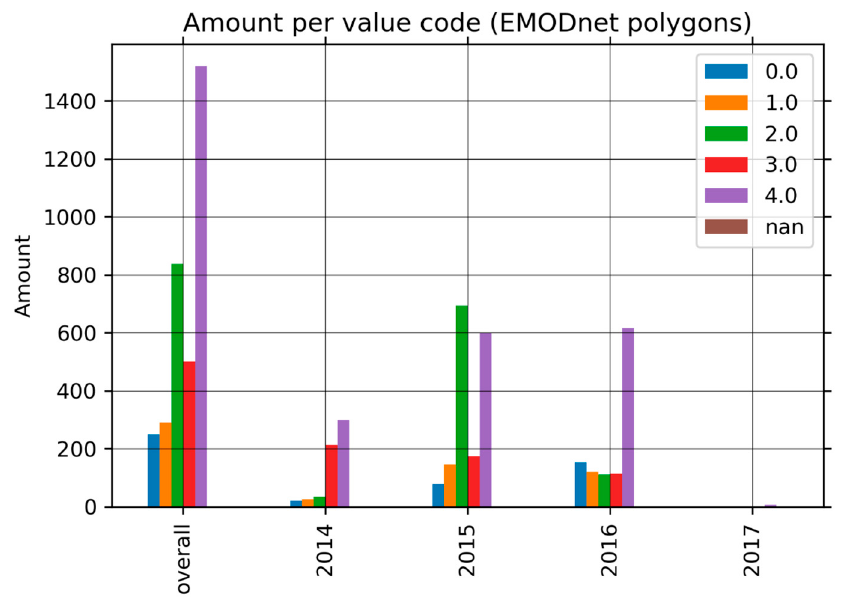
Figure A3. Value code per year within EMODnet polygons dataset.